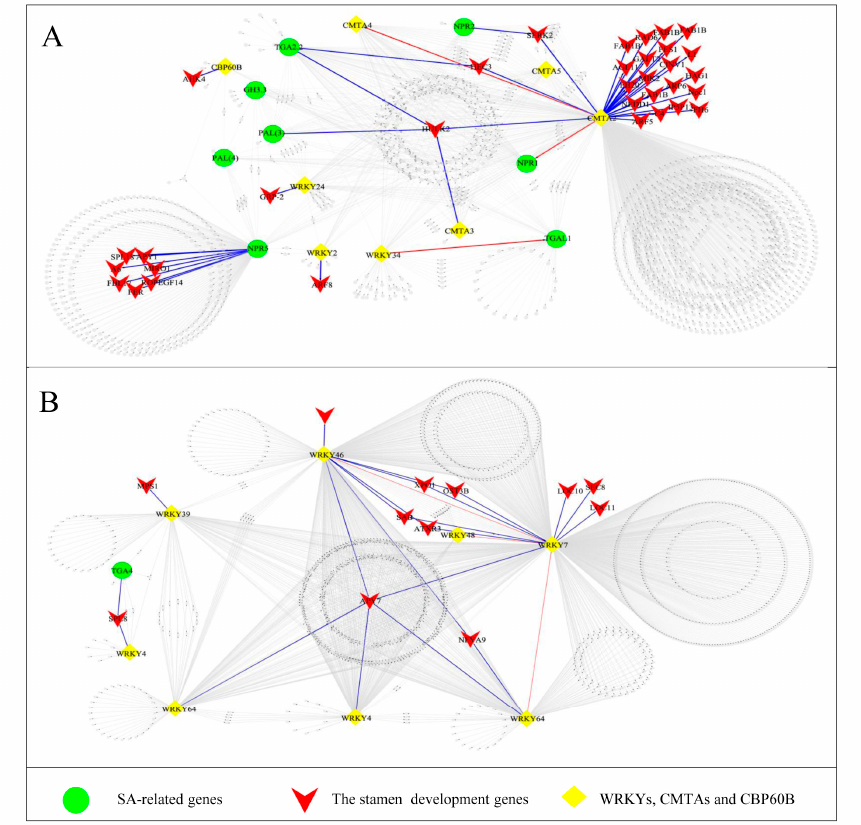
Figure 4. Co-expression networks analysis of genes in salicylic acid (SA) of female flowers. ( A , B ) Co-expression networks analysis of stamen development genes and SA-related